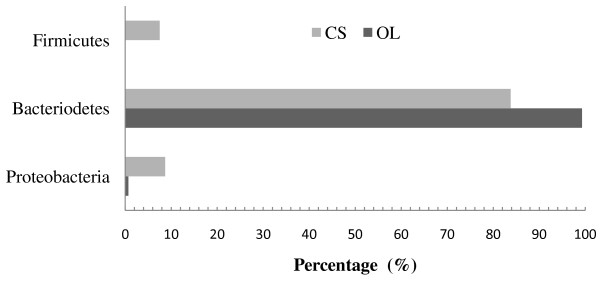
Composition of 16S rRNA gene libraries at the phylum level. Clones obtained from the OL and CS groups representing by black and grey bars, respectively.